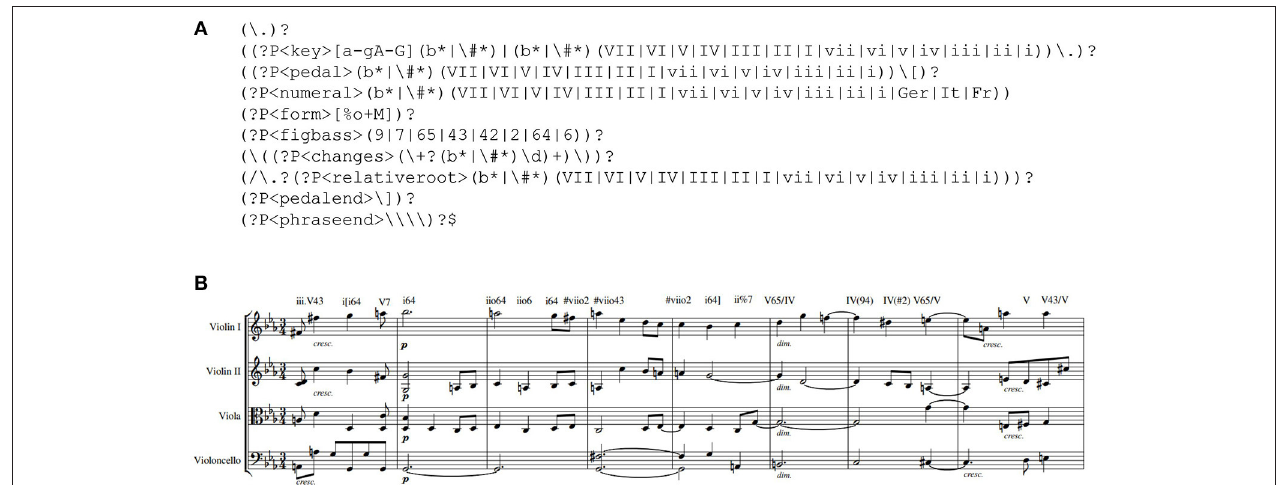
FIGURE 1 | (A) Regular expression for chord symbols, (B) Example analysis from op. 127, first movement, mm. 40–48.